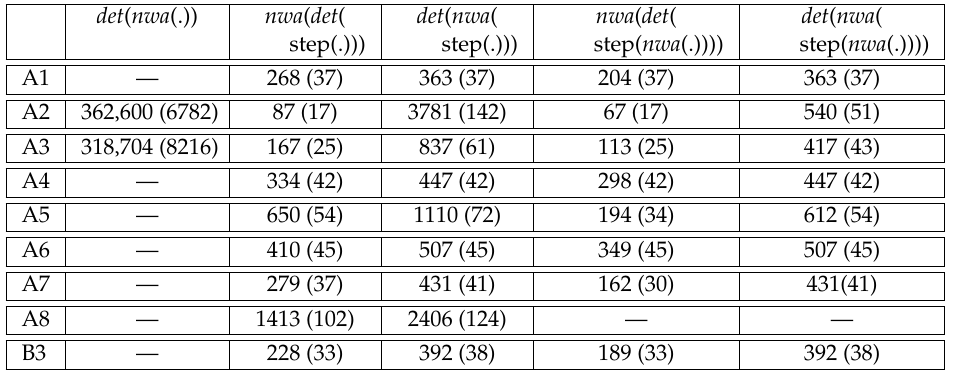
Figure 26. Deterministic NWAs computed with optimizations for the XPath benchmark queries. Note that different dNWAs for the same query may recognize different languages, due to schema-based cleaning with respect to the X ML data model. Furthermore, our implementation of the minimization algorithm for the subclass of dSHA s worked successfully only for dSHA s with at most 200 states.